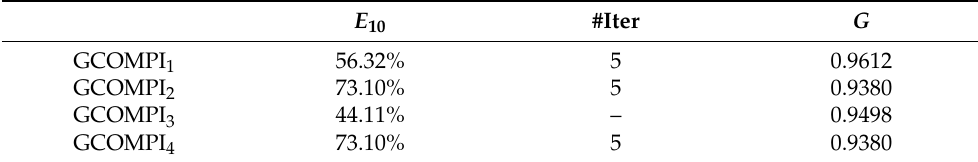
Table 4. Results of the procedure for the four indicators with ρ =